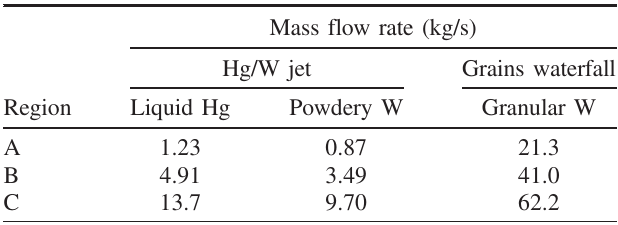
TABLE II. Mass flow rate in three different regions of the jets and the grain